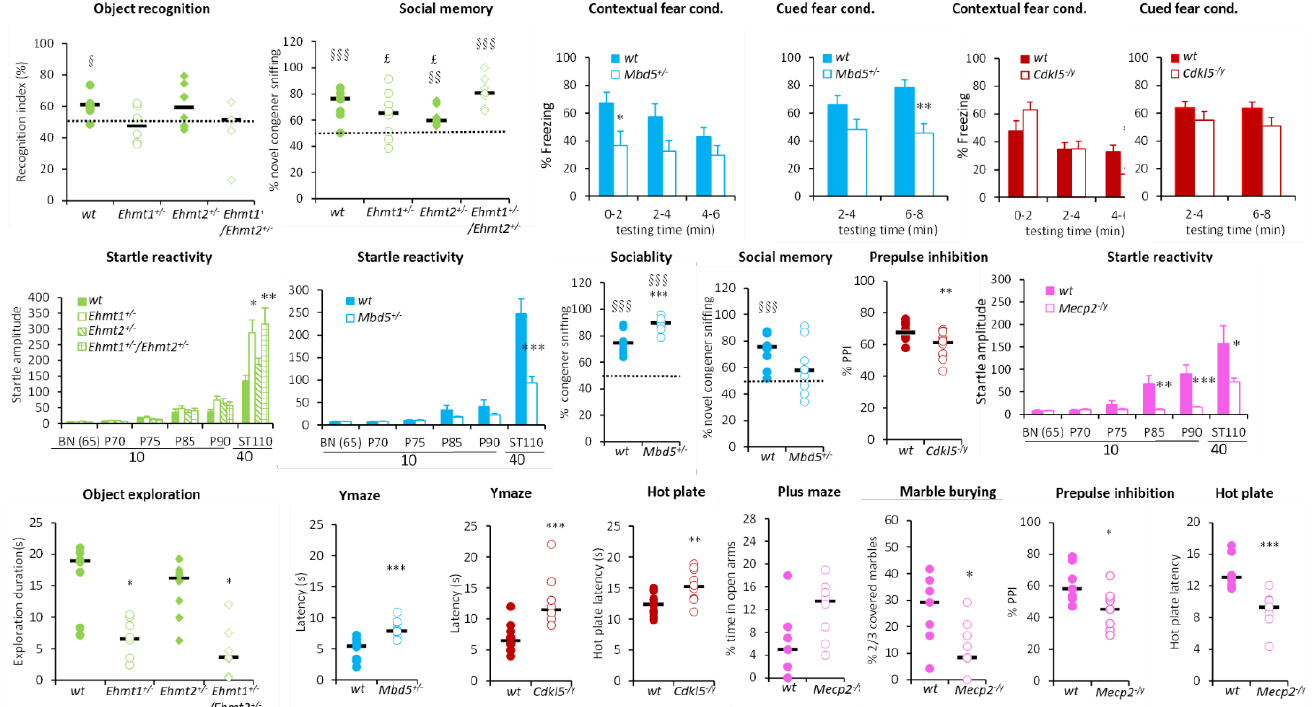
Figure 4. Selected behavioural alterations in the hypoactivity group. Ehmt1 +/ − , Ehmt1 +/ − /Ehmt2 +/ − , Mbd5 +/ − showed altered memory performance in the fear conditioning (decreased % of freezing), object recognition (recognition index) or social tests (% novel congener sniffing). Mbd5 +/ − and Mecp2 − /y had decreased startle while Ehmt1 +/ − , Ehmt1 +/ − /Ehmt2 +/ − had improved startle. Ehmt1 +/ − , Ehmt1 +/ − /Ehmt2 +/ − , Mbd5 +/ − and Cdkl5 − /y showed increased anxiety in the open field (decreased object exploration) or in the Y-maze (increased latency). Mecp2 mutants show decreased anxiety in marble burying (decreased number of marbles covered) and in the plus maze (increased %time in the open arms) and decreased pain threshold. Data are mean ± SEM (fear conditioning, startle reactivity) or scattergrams with the median (object recognition, social test, Y-maze, marble burying, hot plate). Data are analysed using either repeated measures ANOVA followed by t -tests or Student’s t -test for single time points. * p < 0.05, ** p < 0.01, *** p < 0.001 vs. WT; § p < 0.05, §§ p < 0.01, §§§ p < 0.001 vs. the chance level; £ vs. Ehmt1 +/ − /Ehmt2 +/ − .